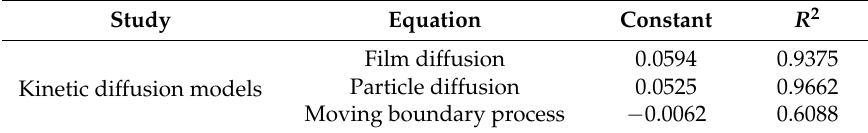
Table 4. Adsorption mechanism kinetic parameters for Cu 2+ adsorption onto CNF.